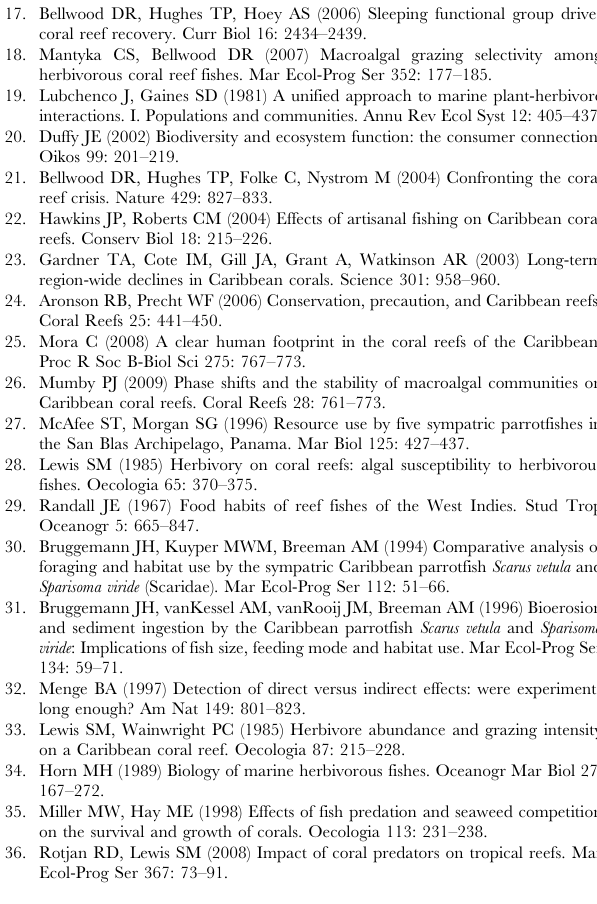
Table S1 Year 1 results from repeated measures, two-factor ANOVA of percent cover data. Significant effects are highlighted in bold.